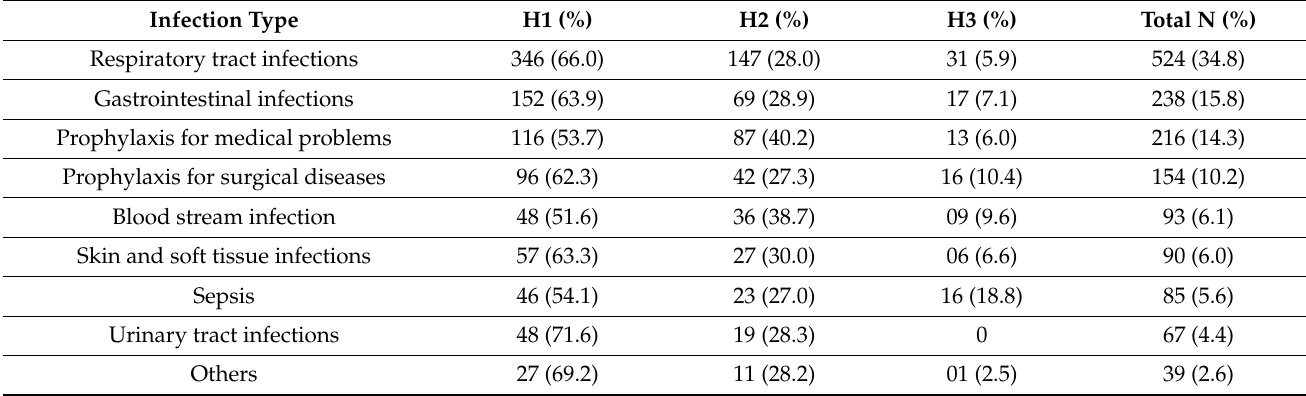
Table 4. Indications for prescribed antibiotics among the study participants.